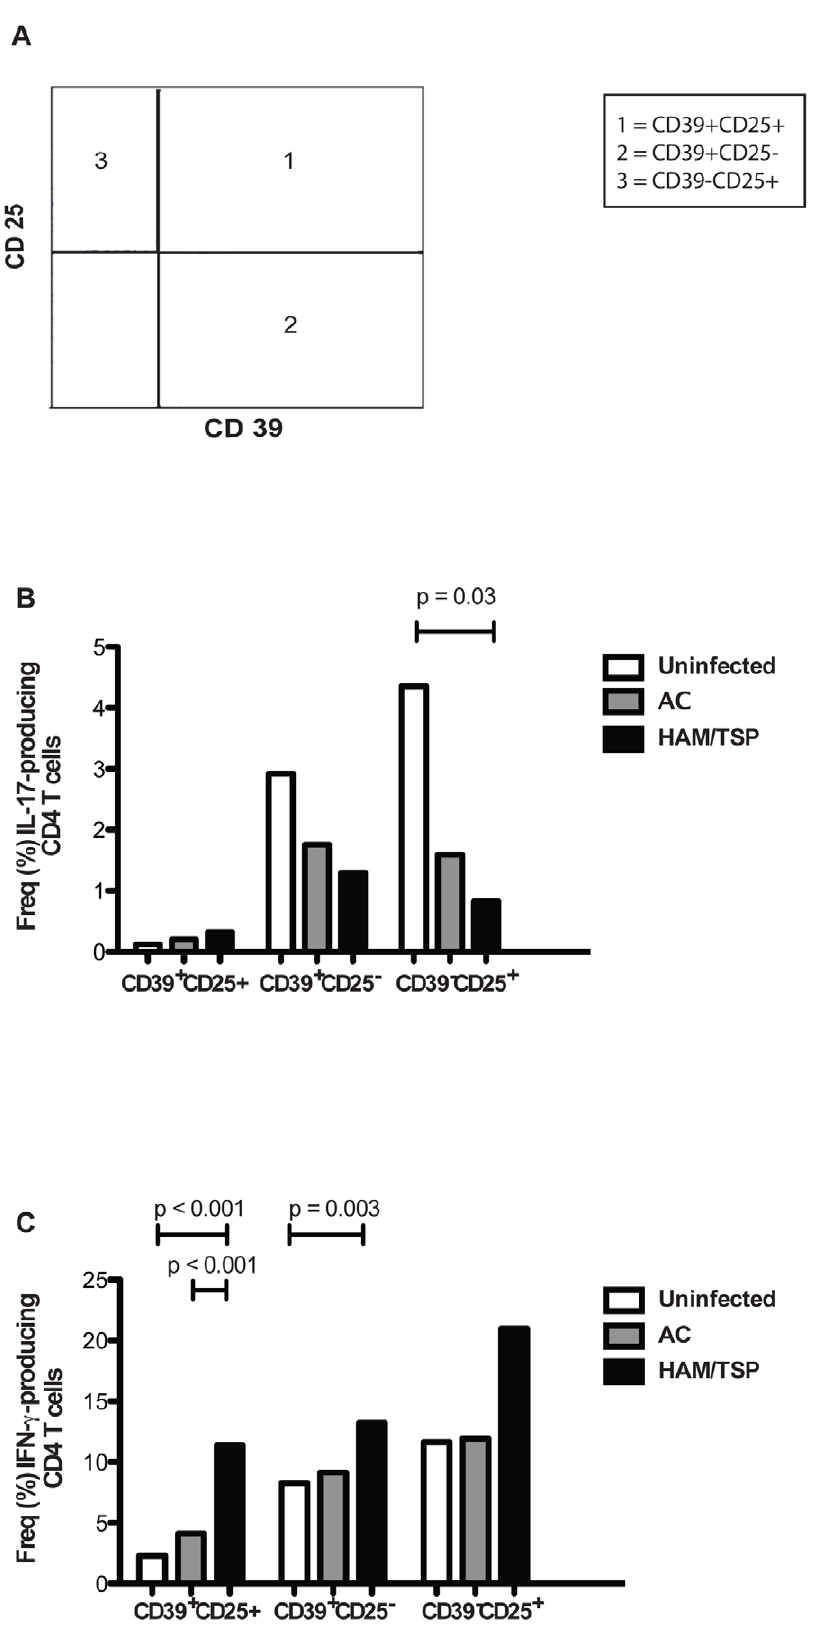
Figure 5. IL-17 and IFN- c production by CD4 + T cells subsets. Subsets were numbered according to CD39 and CD25 expression (A): 1=CD39 + CD25 + ; 2=CD39 + CD25 2 ; 3=CD39 2 CD25 + . Graph shows median of proportion of (B) IL-17-producing CD4 + T cells and (C) IFN- c -producing CD4 + T cells subsets after PMA and ionomycin stimulation on PBMCs from 9 uninfected, 8 HTLV-1-infected asymptomatic carriers and 10 HAM/TSP patients. The statistical difference was deemed significant using a Mann-Whitney U test analysis if p , 0.05. doi:10.1371/journal.pntd.0002028.g005 PLOS Neglected Tropical Diseases |